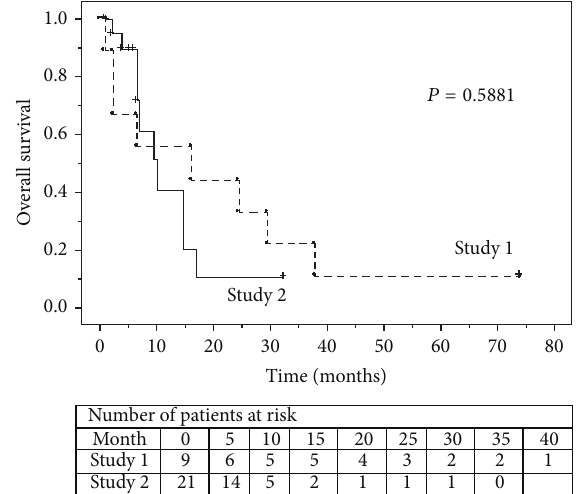
Figure 3: Kaplan-Meier estimated overall survival is shown for patients treated with survivin-2B80–88 peptide plus IFA (Study 1) versus survivin-2B80–88 peptide plus IFA in combination with IFA alpha (Study 2). IFA: incomplete Freund’s adjuvant; IFN: interferon.